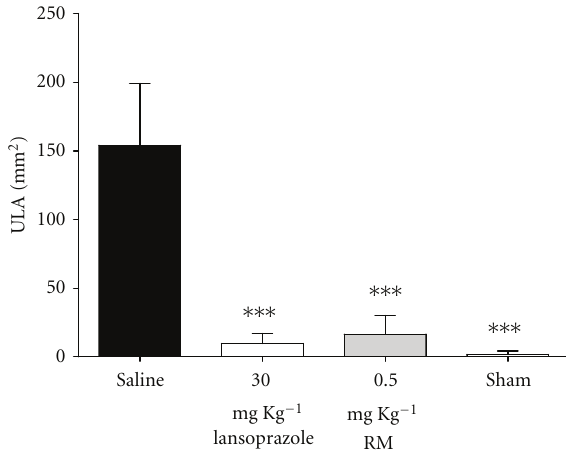
Figure 2: E ff ect of pretreatment with RM on ethanol-induced gas- tric ulcer in rats. The animals received 0.9% saline solution (vehi- cle), lansoprazole (30mgkg − 1 ), and RM (0.5, 1.5, and 3.0 mgkg − 1 ); sham group represents the manipulated animals. The results are expressed as mean ± s.d. ( n = 8), and statistical significance was determined by one-way analysis of variance (ANOVA) followed by Dunnett’s post-hoc t test, ( P < 0 . 05 ∗ and P < 0 . 001 ∗∗∗ ).